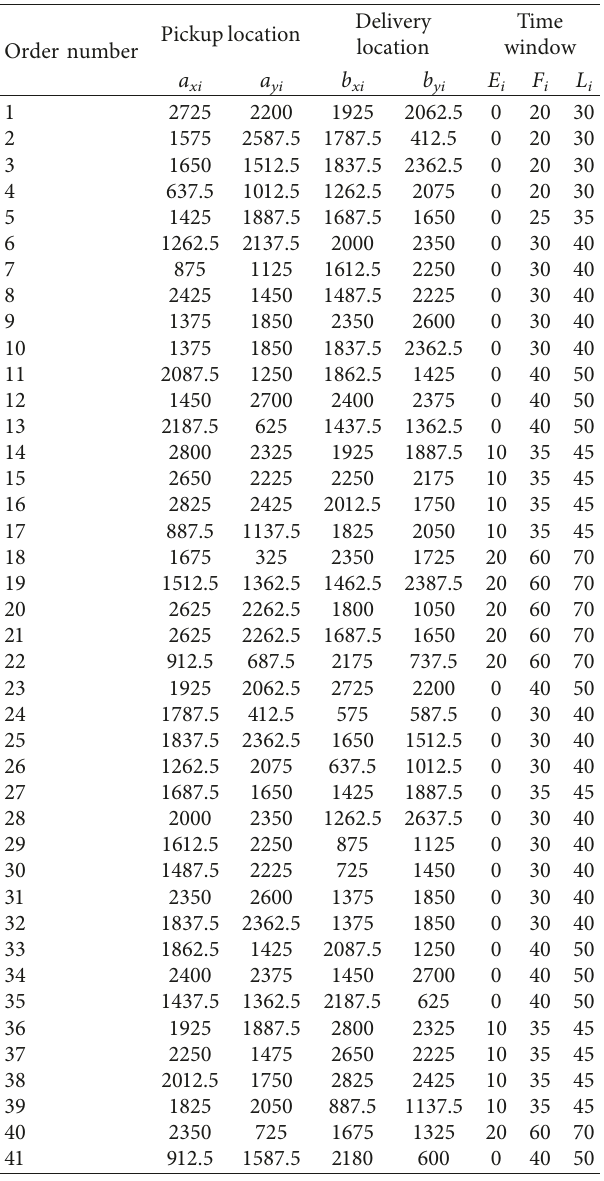
Table 3: Location and time data of forty-one meal orders. Pickup Order number